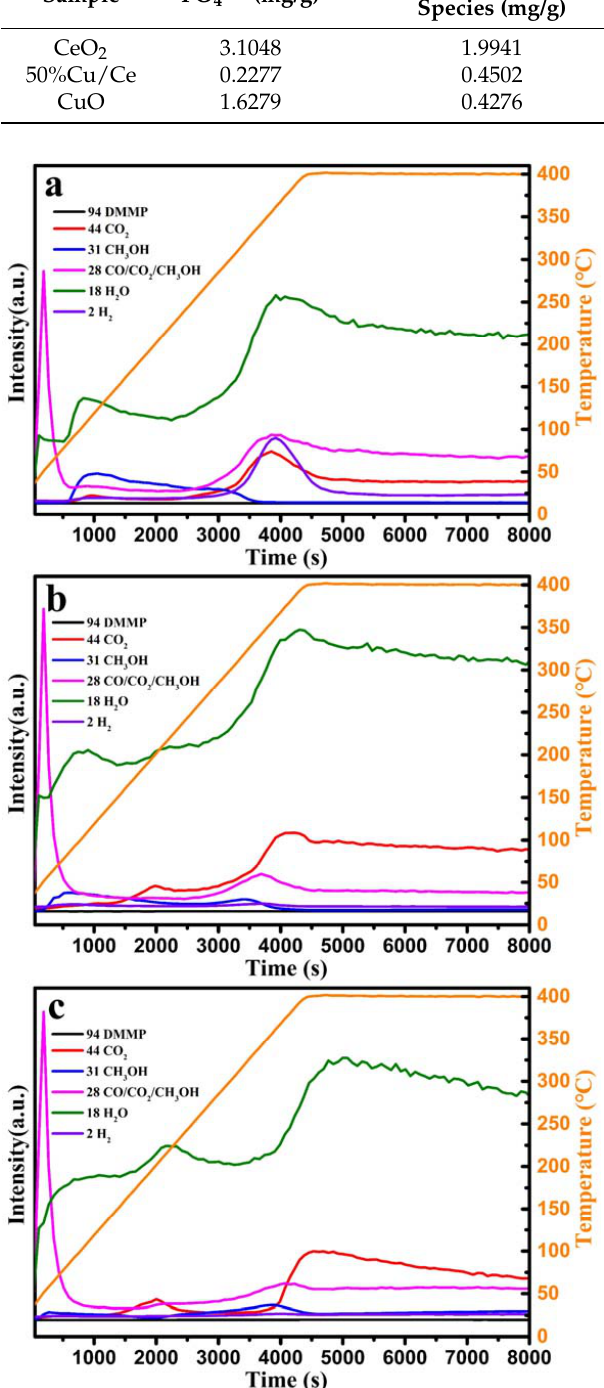
Figure 13. Mass spectrometry analysis of the tail gas generated from DMMP thermocatalytic decomposition on ( a ) CeO 2 , ( b ) 50%Cu/Ce, and ( c ) CuO. Table 7. Content of PO 43 − , methyl phosphonate species, DMMP decomposition, and P element on various catalysts after the catalytic decomposition of DMMP. Sample